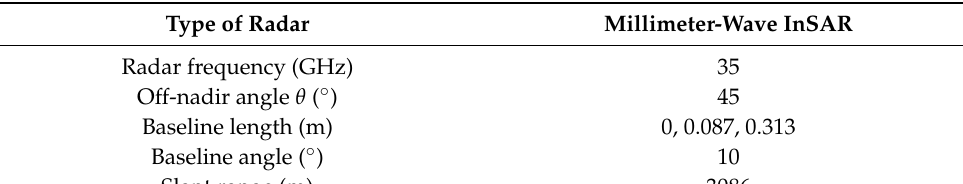
Table 2. System parameters of airborne InSAR.